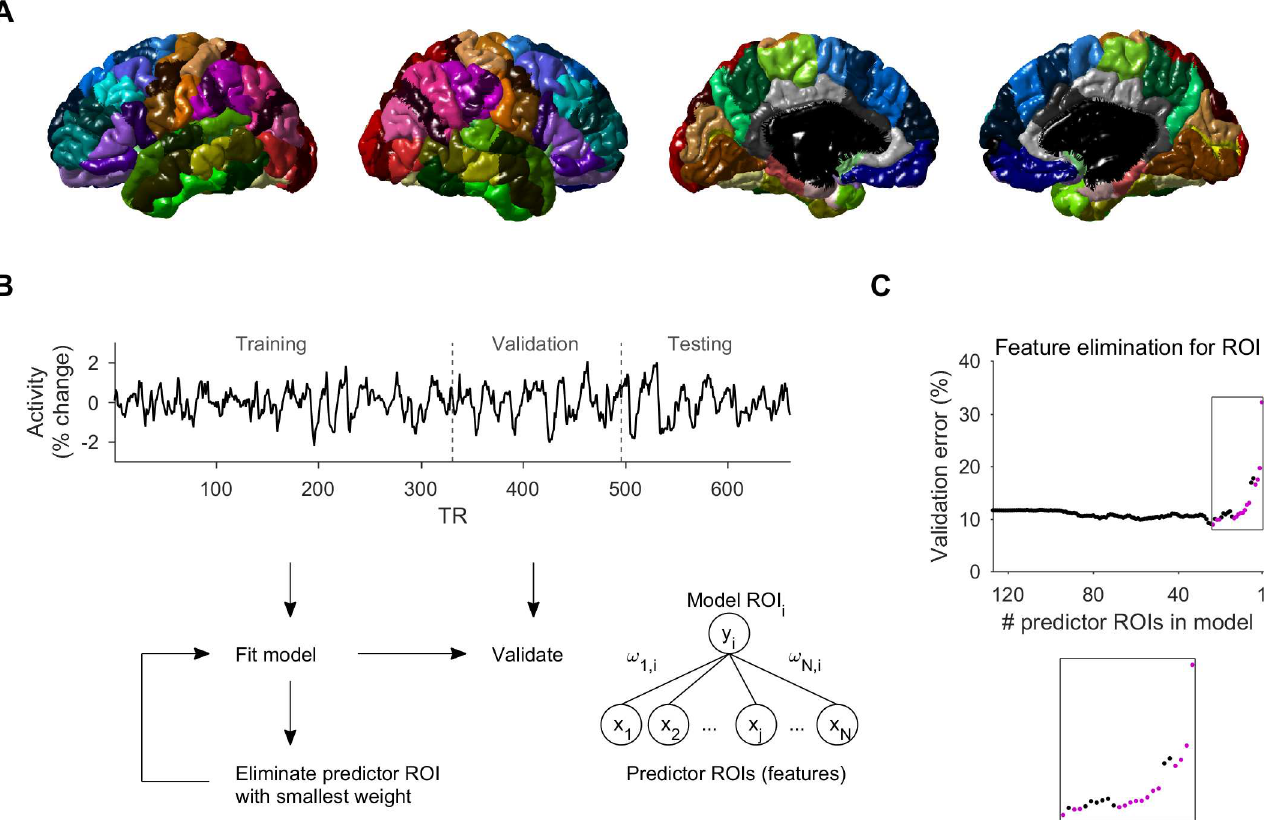
Fig 1. Recursive feature elimination for a region of interest. A. Brain volume was dividedto 128 ROIs using anatomicalfeatures (see Methods). Lateral and medial views of both hemispheres show the 112 cortical ROIs. B. The activity data was dividedinto segments (training,validation and testing). The model for an ROI expressed the activity as a weightedsum of the observedactivities in predictor ROIs (“features”), and predictor weightsthat best fitted the trainingdata segment were found by regression.Models were generatediteratively, and in each iteration the predictor ROI with smallest weight was eliminated.The validationerror of each model was assessed using the validation data segment. C. Validationerror (in % of the activity variance)of each model for the ROI duringthe RFE process as a function of the number of predictor ROIs in the model. Models in magentaare from iterations where predictor eliminationresultedin an increase of the smallest validationerror across the rest of the iterations that followed.These predictor ROIs were used to generatethe final model. In an alternativemethod (RFE2), the final model was the one with the minimumvalidationerror duringthe recursiveeliminationprocess (minimum of the curve).